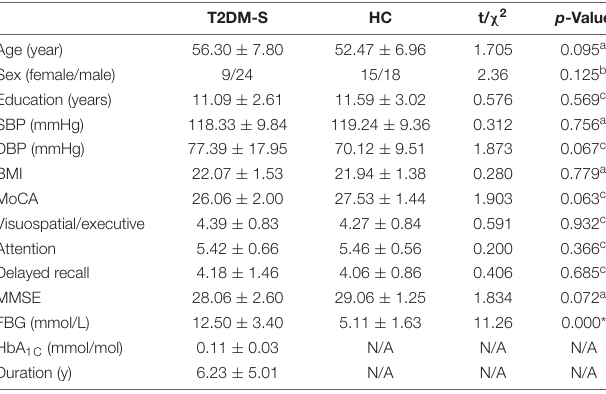
TABLE 1 | Demographic and clinical characteristics for each